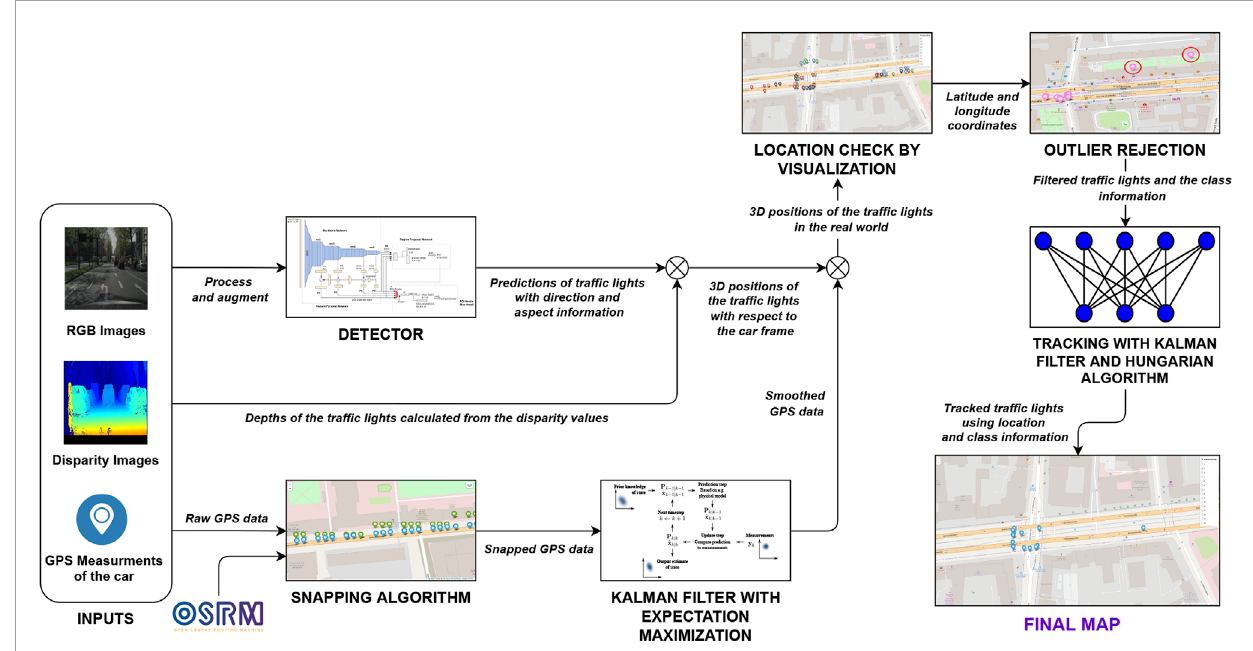
FIGURE 2 Schema of our pipeline for traffic lights map creation. The input of the system are RGB images, disparity maps and GPS positions of the vehicle. The output is a map with the GPS position of all detected lights.